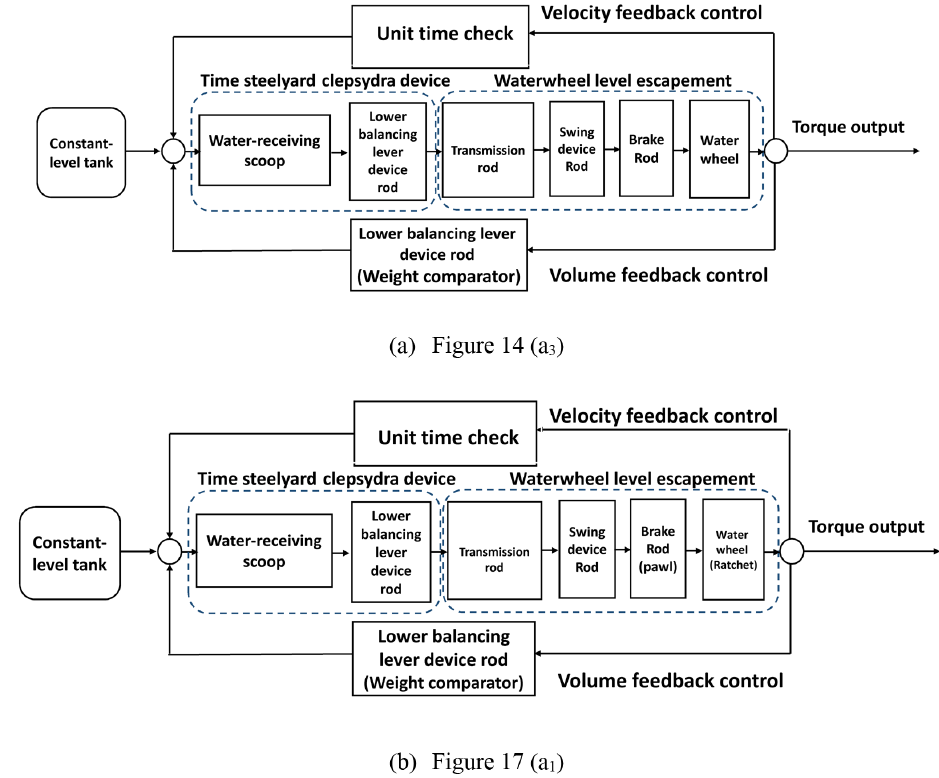
Figure 19. Kinematic analysis for the waterwheel steelyard clepsydra.